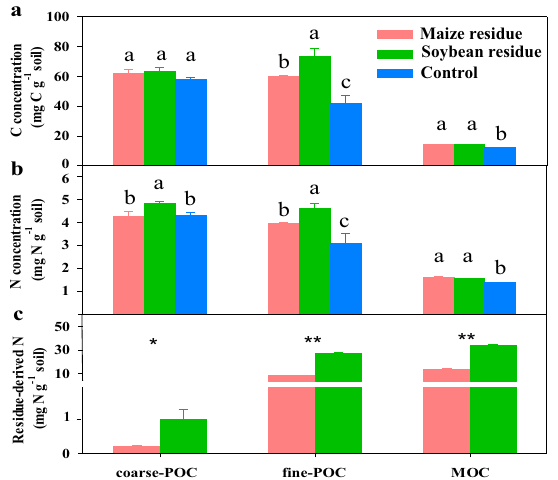
Fig. 1 Carbon and nitrogen concentrations in various fractions of soil organic matter. The concentrations of carbon ( a ) and nitrogen ( b ) and residue-derived N ( c ) retained in the coarse particulate organic C (coarse-POC), fi ne POC ( fi ne-POC) and mineral-associated organic C (MOC) fractions in soils amended without (control) and with maize and soybean residues after incubated at 25 °C for 250 days. Different letters above bars indicate a signi fi cant difference between treatments at p < 0.05 (one-way ANOVA). * and ** represent a signi fi cant difference analyzed by independent t test between treatments at p < 0.05 and p < 0.01, respectively. Error bars are the standard error of three replicates.